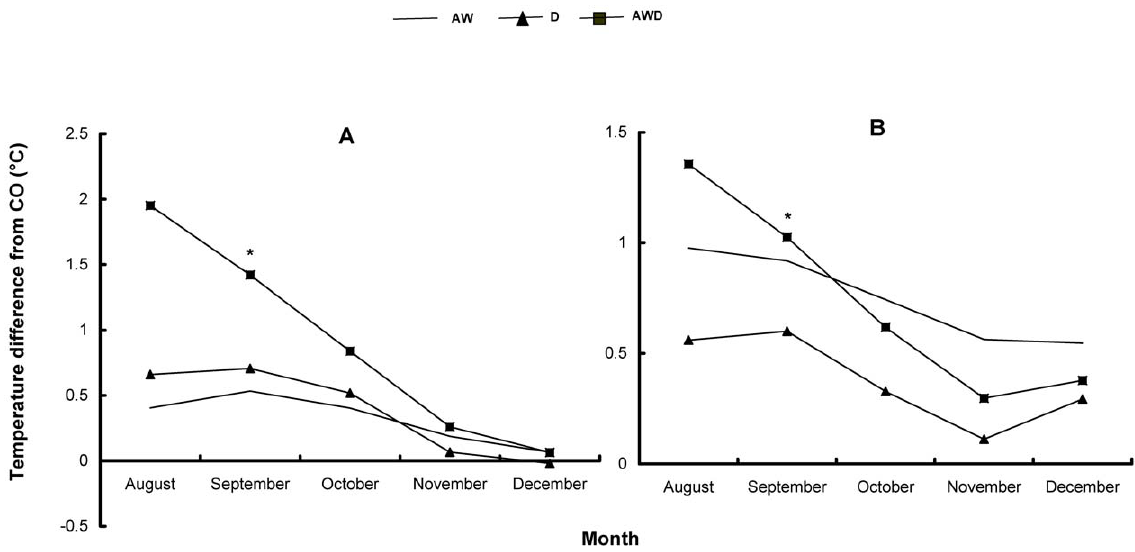
Figure 2. Effects of climate treatments and soil types on soil surface temperature. Mean surface temperature relative to controls (CO) in acid (A) and calcareous (B) soils as affected by the treatments: AW=air warming, D=drought, and AWD=air warming + drought in 2007, where * indicates a significant difference from CO ( P , 0.05, n=4).